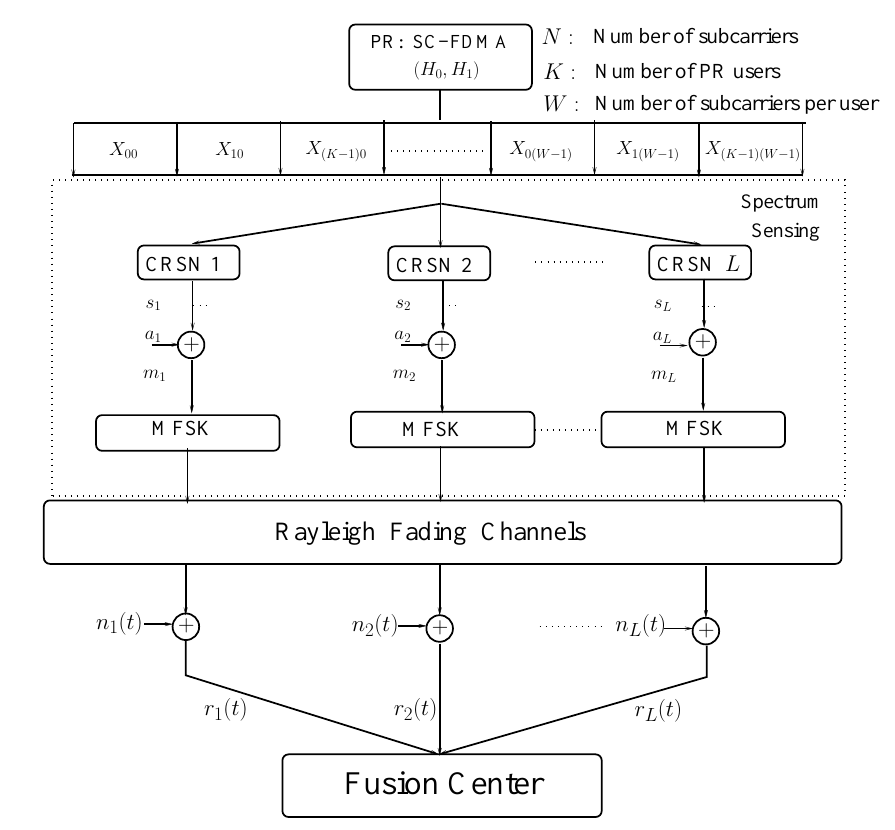
Figure 1. System model for the FH/MFSK SSN sensing an IFDMA PR